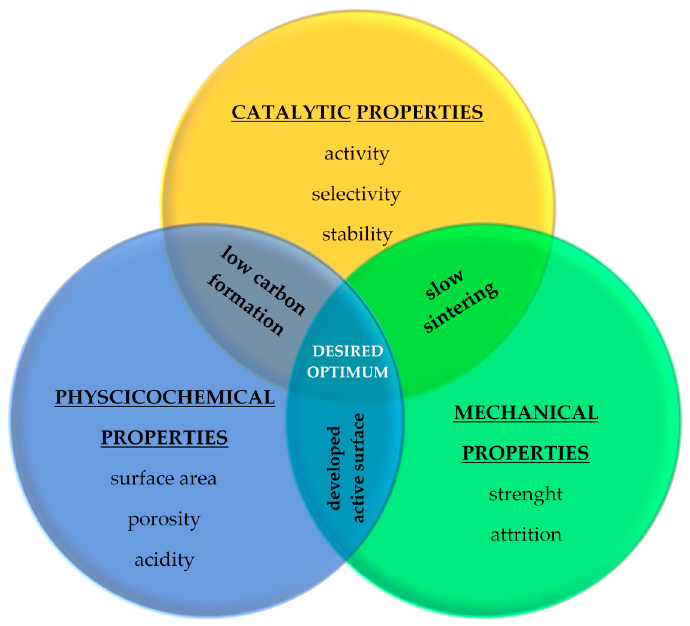
Figure 8. The catalyst design concept.